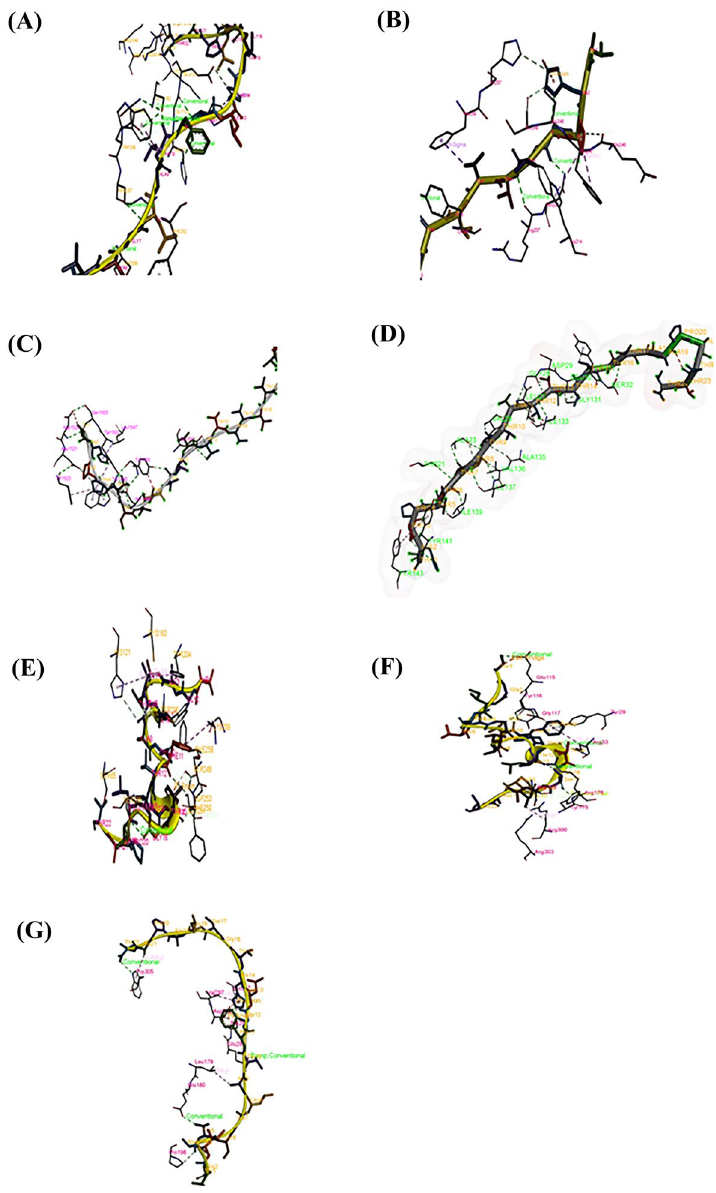
( E ) AtMP2-Caspase9 docking model, ( F ) AtMP2-P53 docking model, ( G ) AtMP2-BCL-2 docking model. The results showed the interaction site between the peptides and the selected cell proteins (original images are shown in Supplementary Figures S25, 26, 27, 28, 29, 30,